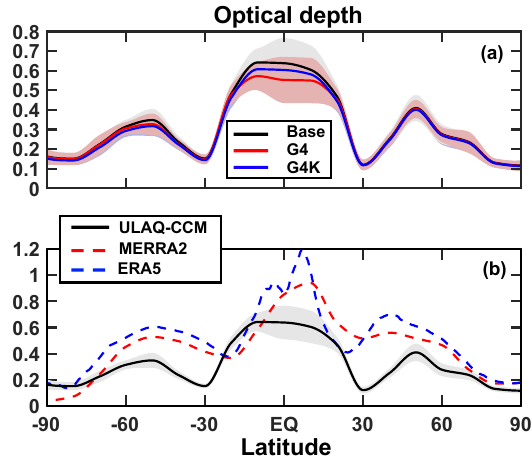
Figure 13. Zonally and time-averaged values of the ice optical depth ( λ = 0 . 55µm) for the ULAQ-CCM Base, G4 and G4K ex- periments (solid black, red and blue lines, respectively) (a) and Base case comparison with the MERRA-2 and ERA5 indirectly de- rived values (dashed red and blue line) (b) . The model results are for years 2030–2069; the MERRA-2 and ERA5 data are for years 2003–2012. The shaded area represents ± 1 σ for the ensemble over the 40-year period